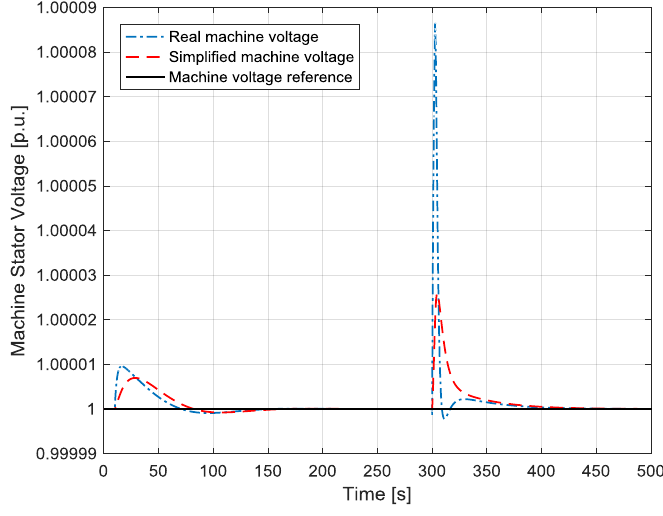
Figure 19. Active power time profile.